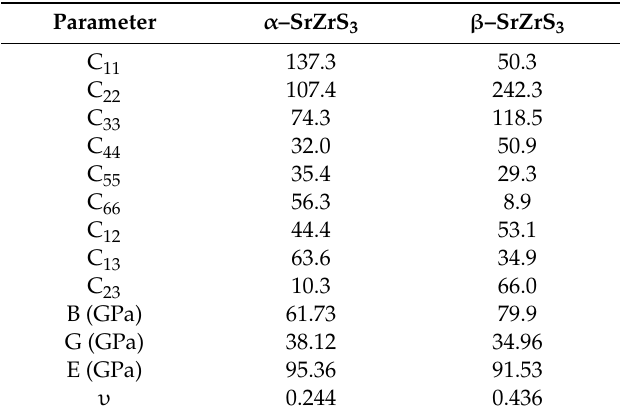
Table2. Elasticconstants(C ij ), bulkmodulus(B),shearmodulus(G),Young’smodulus(E),andPoisson’s ratio ( v ) of α –SrZrS 3 and β –SrZrS 3 .